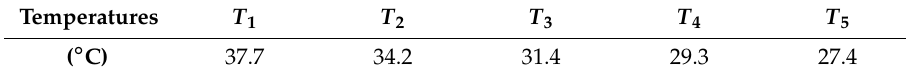
Table 5. Temperature values of sensors S1–S5 for a certain moment of the permanent regime.